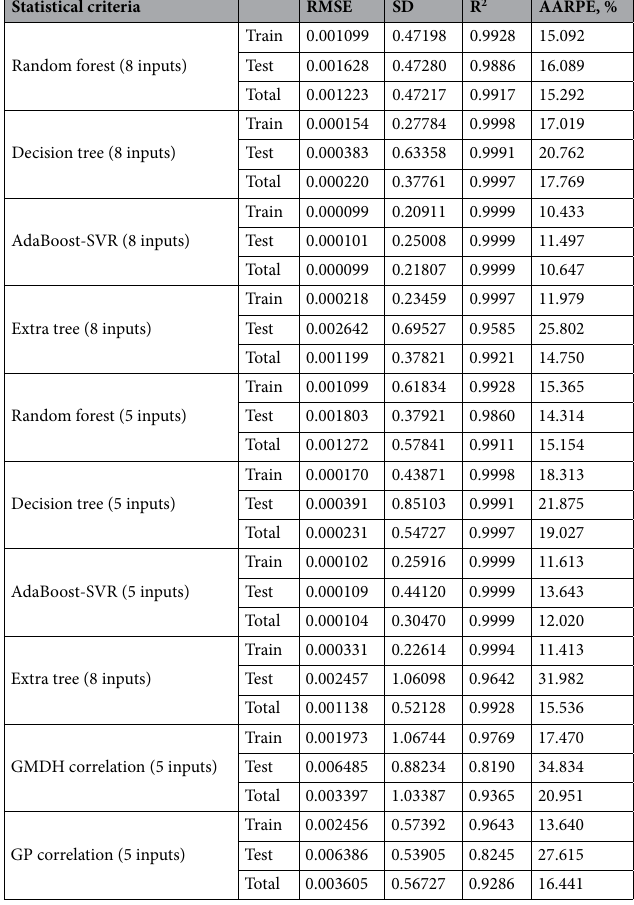
Table 3. Statistical error analysis for the developed models and